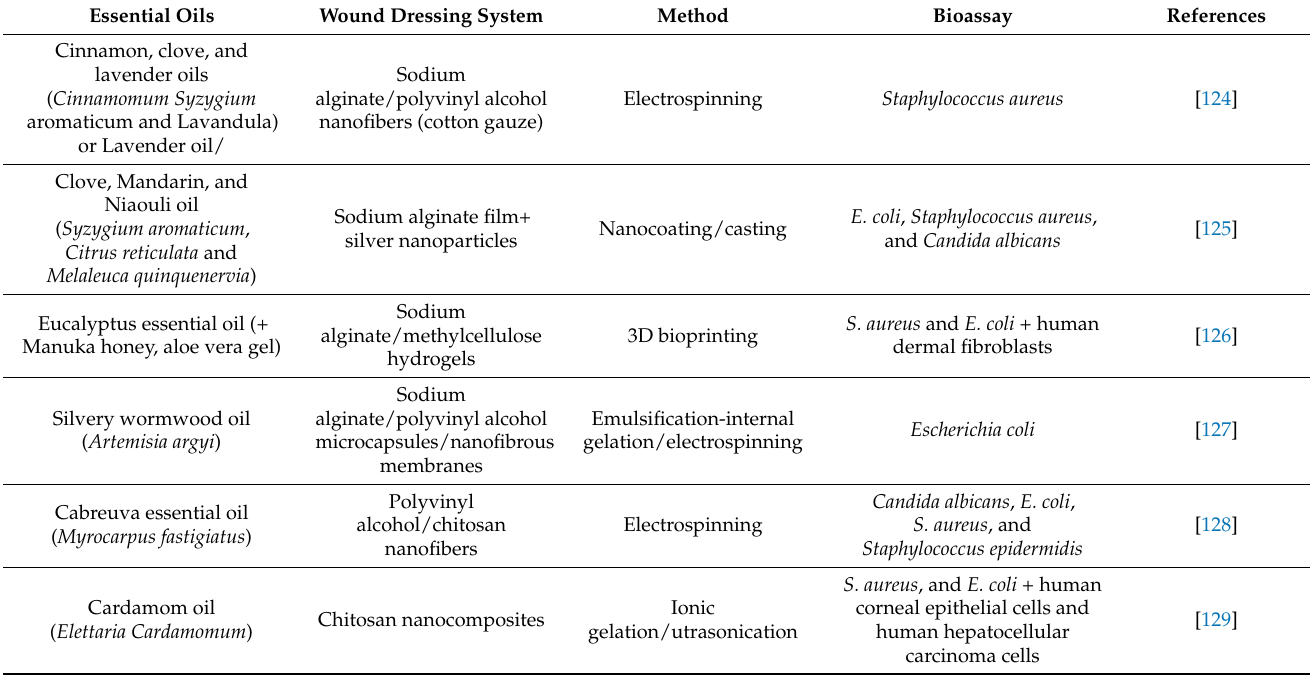
Table 1. Essential oil applications for wound